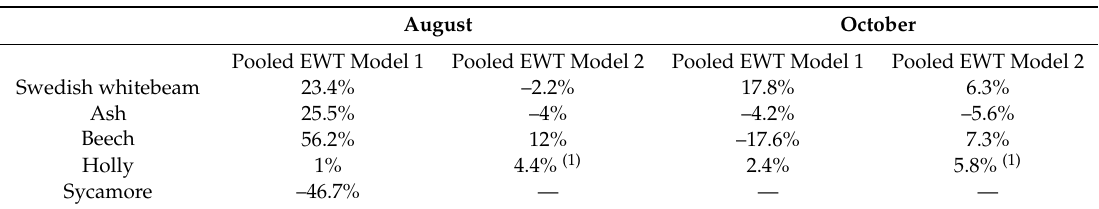
Table 4. Errors in EWT estimations for the August and October datasets. Pooled EWT Model 1 refers to the model including holly, while pooled EWT Model 2 is the model excluding